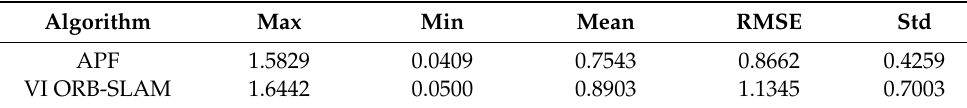
Table 4. Error analysis between the proposed algorithm and the ROVIO algorithm (pose: 29,993).